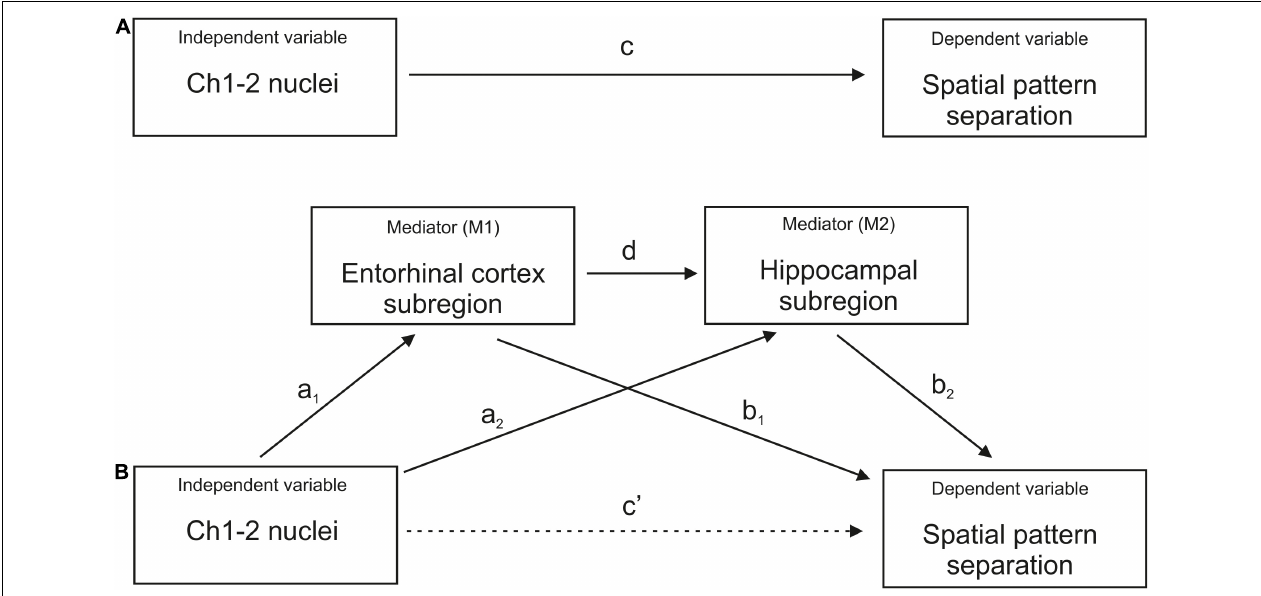
FIGURE 2 | Mediation analysis. (A) The total effect represents the association between Ch1-2 nuclei and spatial pattern separation performance without the mediators (c path). (B) The direct effect represents the association between Ch1-2 nuclei and spatial pattern separation performance accounting for the mediators (c’ path). The indirect effect represents the association between Ch1-2 nuclei and spatial pattern separation performance through the mediators (a1*b1, a2*b2, and a1*d*b2 paths). The indirect effect includes the associations between Ch1-2 nuclei and specific entorhinal cortex and hippocampal subregions (a1 and a2 paths), the associations between specific entorhinal cortex and hippocampal subregions and spatial pattern separation performance (b1 and b2 paths) and the association between the entorhinal cortex subregion and the hippocampal subregion (d path). Each entorhinal cortex and hippocampal subregion that was significant in the regression analysis was included separately as the